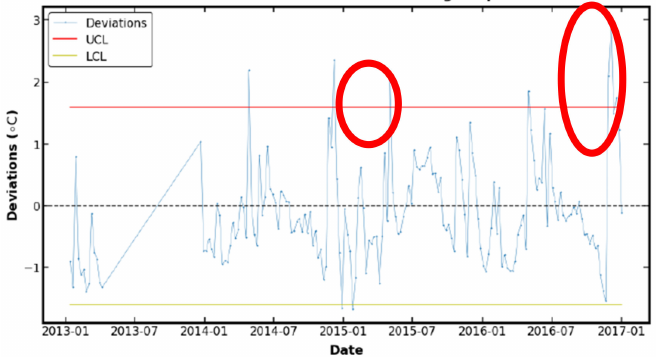
Figure 23. EWMA Chart for Generator Bearing Temperature Deviation in